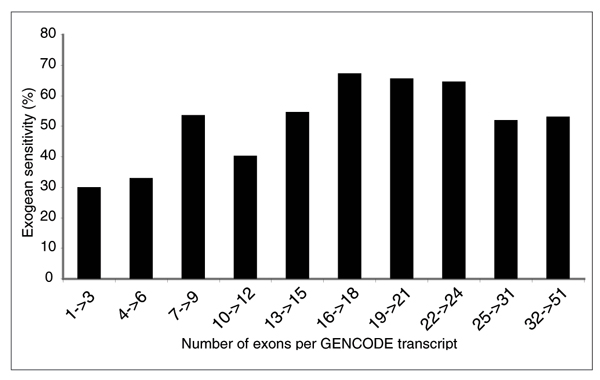
Histogram of Exogean's sensitivity in predicting exact GENCODE transcripts as a function of the number of exons in the latter. Clearly, GENCODE transcripts with larger numbers of exons are better identified than smaller transcripts.